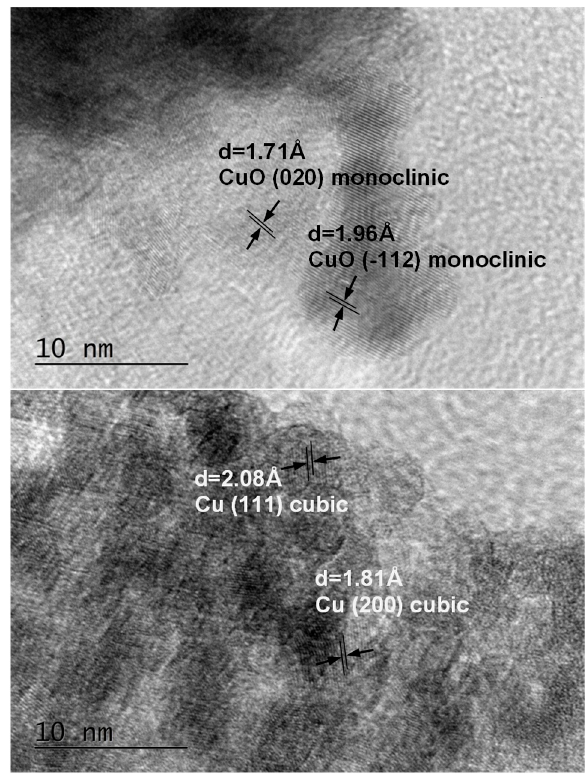
Figure 4. The HRTEM micrographs of Au/CuMn (2:1) catalyst tested in a WGS reaction at a magnification 600,000 × .